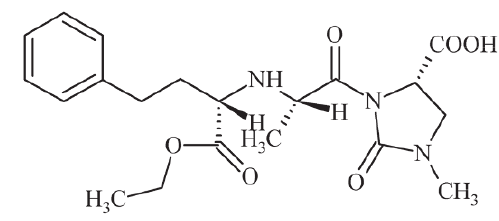
Figure 1. Molecular structure of imidapril hydrochloride